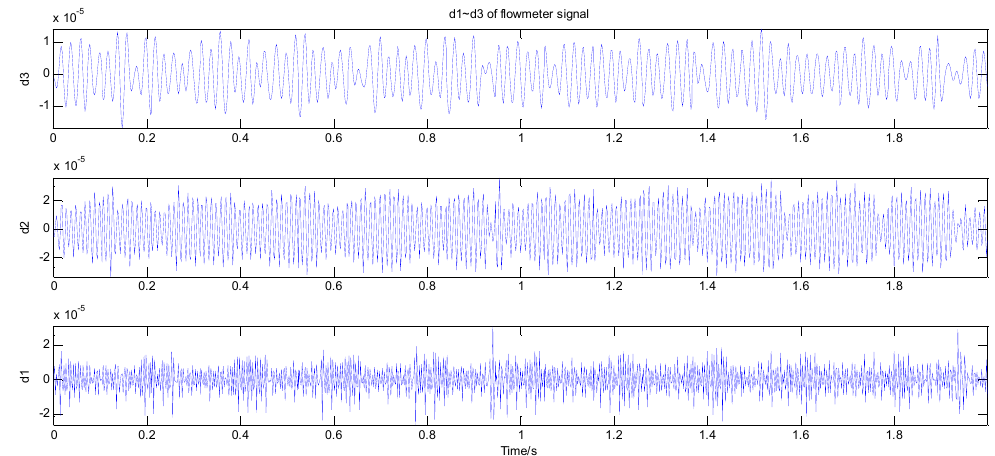
Figure 5. The high-frequency part of the wavelet decomposition.